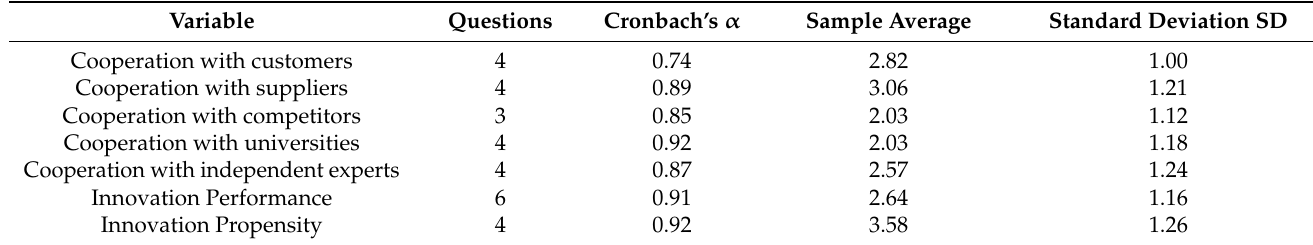
Table 6. Statistical summary of validity of variables assessed through a Likert